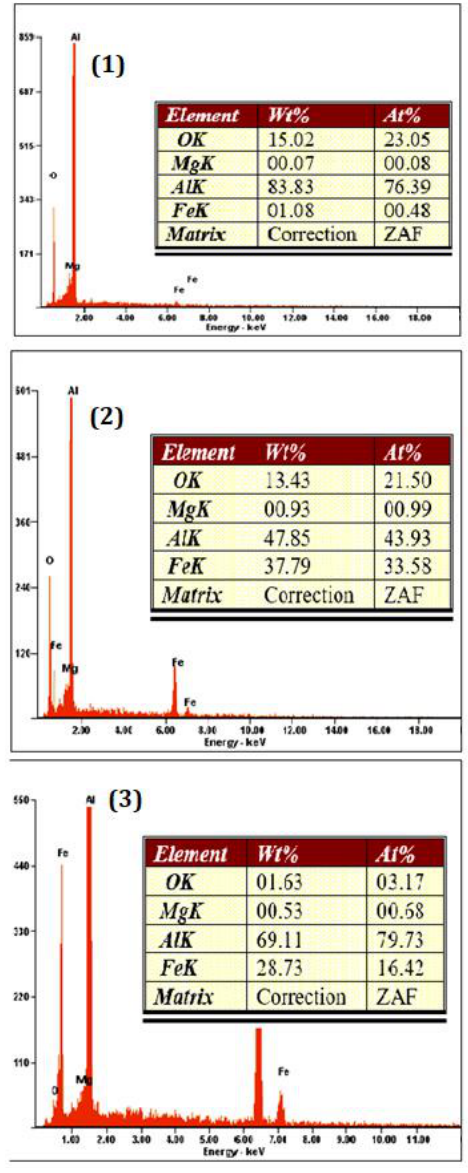
Figure 6. The EDS spectrum of a.5 composition ( 1 ) Al, ( 2 ) Fe 3 O 4, and ( 3 ) Al 3 Fe.